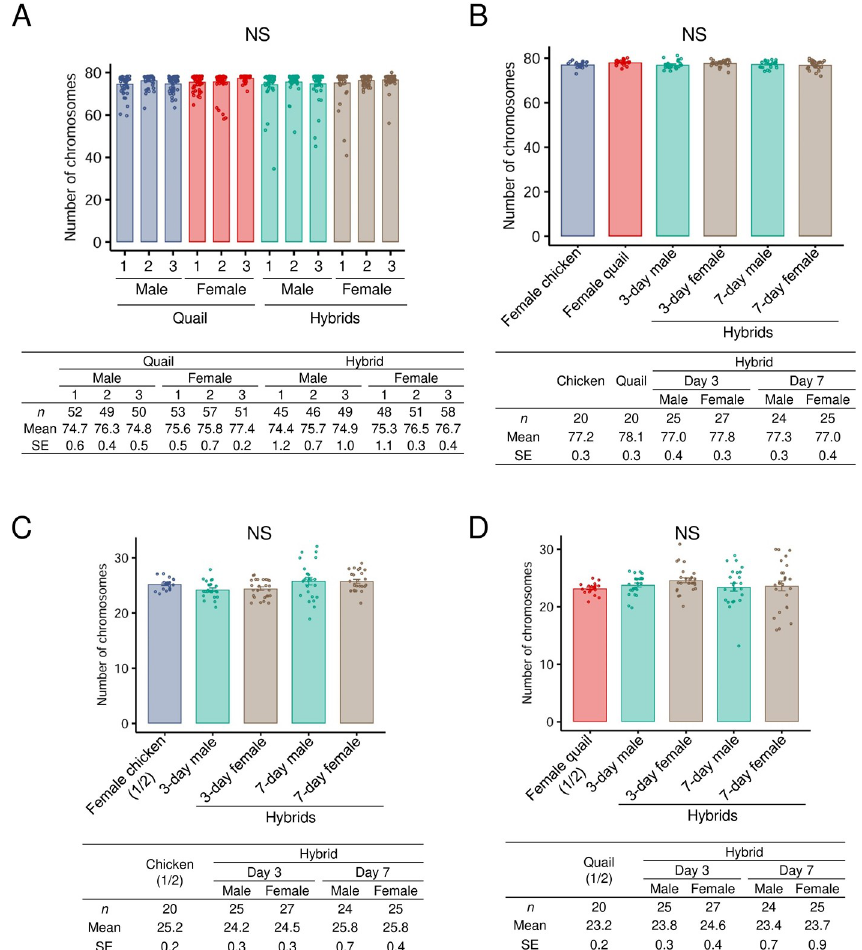
Fig 3. Number of chromosomes in parental species and their F 1 hybrids. A. Total number of chromosomes in blastodermal cells of quail and the hybrids. Three males and three females were used for each group. The number of chromosomes was not different among individuals (Tukey-Kramer test, P > 0.05). NS, not significant. B. Total number of chromosomes in fibroblast cells from 3- or 7-day-old male and female hybrid embryos and those from 3-day-old female embryos of parental species. The number of chromosomes was not different among them (Tukey- Kramer test, P > 0.05). C. The number of chromosomes hybridized with GGA-TaqI-8 in 3-day and 7-day-old male and female hybrid embryos. In 3-day female chickens, a half of the total number of microchromosomes per nucleus, which were detected with GGA-TaqI-8, is shown. The number of chicken-derived microchromosomes in the hybrids did not deviate from half the number of GGA-TaqI-8-positive microchromosomes in chicken cells (Tukey-Kramer test, P > 0.05). D. The number of chromosomes hybridized with CJA-BglIII-M9 in 3-day and 7-day-old male and female hybrid embryos. In 3-day female quail, a half of the total number of microchromosomes per nucleus, which were detected with CJA-BglIII-M9, is shown. The number of quail-derived microchromosomes in hybrid cells did not deviate from half the number of CJA-BglII-M9-positive microchromosomes in quail cells (Tukey-Kramer test, P >